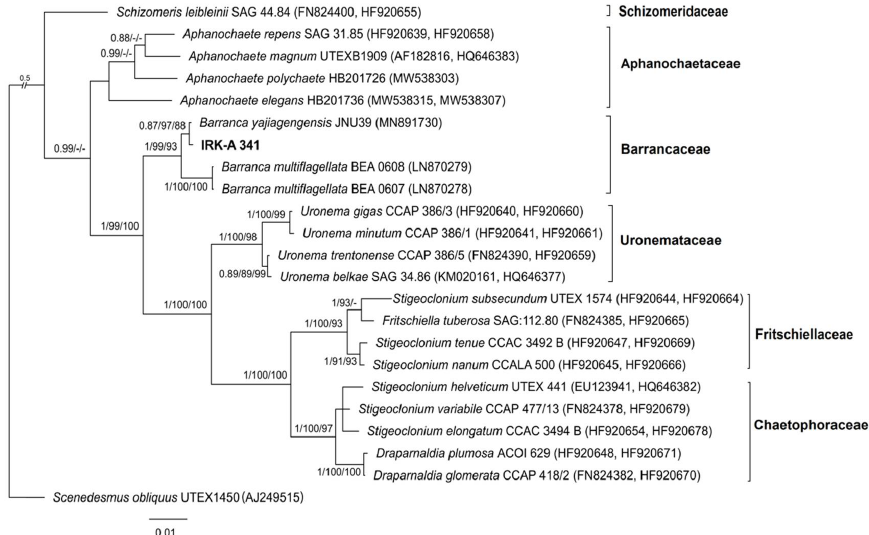
Figure 1. The phylogenetic position of the studied strain IRK–A 341 in the Barranca clade of Chaetophorales. Bayesian phylogenetic tree is based on the 18S-ITS2-28S alignment, 2627 nt in length. Bayesian probability support and bootstrap values (PP/ML/NJ) are given next to branch nodes. Values less than 85 (0.85) are not shown. The studied strain is marked with bold font. GenBank accession numbers are given in parentheses. The scale bar indicates the number of substitutions per site. Scenedesmus obliquus is shown as outgroup.